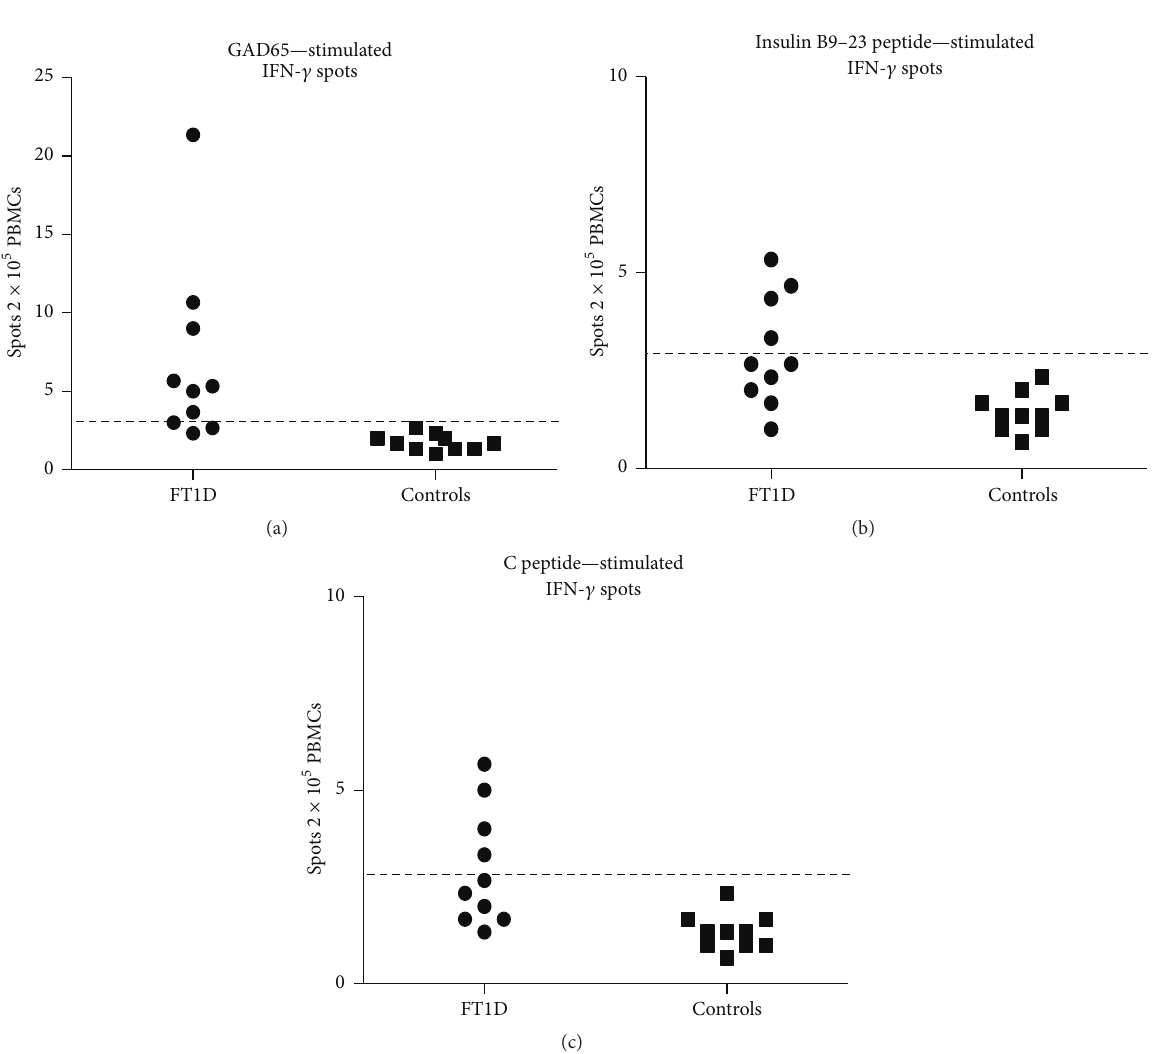
Figure 1: Comparison for the IFN- 𝛾 secretion induced by GAD65 and insulin B9–23 and C peptide. The average spot of all individual IFN- 𝛾 spots are depicted as a separate marker, control subjects (closed squares), and FT1D patients (closed circles). Antigen-stimulated spots were determined as follows: [(the mean number of spots in the presence of antigen) − (the mean obtained without stimulation)]. Each horizontal line represents the mean + 3 SD of the healthy